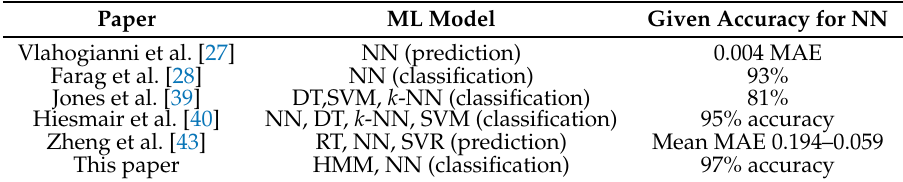
Table 11. Comparison table of this paper with other research in terms of accuracy for NN. Paper ML